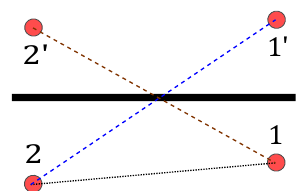
Figure 5. Direct and echo path of UWB